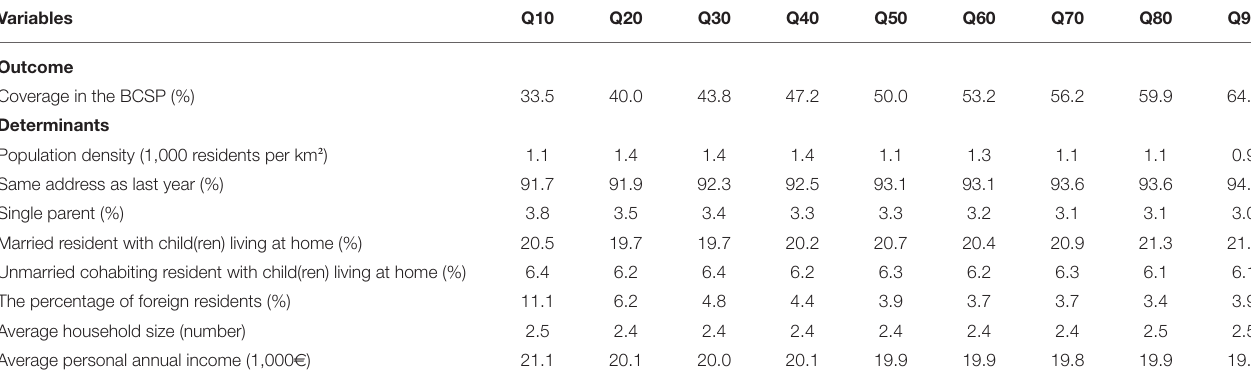
TABLE 1 | Description of the neighborhood-level socio-demographic variables and the coverage in the BCSP at the 10th (Q10) to the 90th (Q90) quantiles*. Variables Q10 Q20 Q30 Q40 Q50 Q60 Outcome Coverage in the BCSP